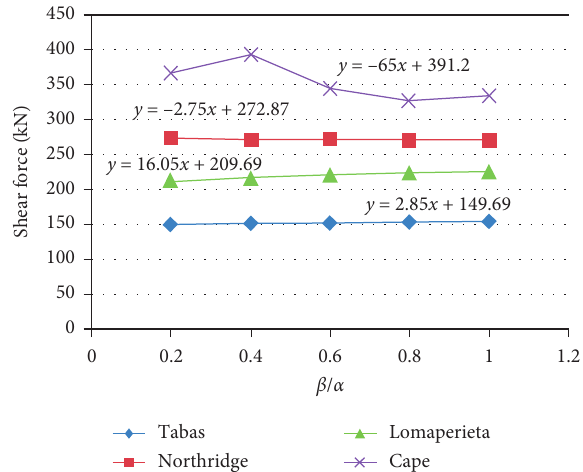
Figure 18: Maximum shear force of tunnel lining ( F ) at load combination 11 to